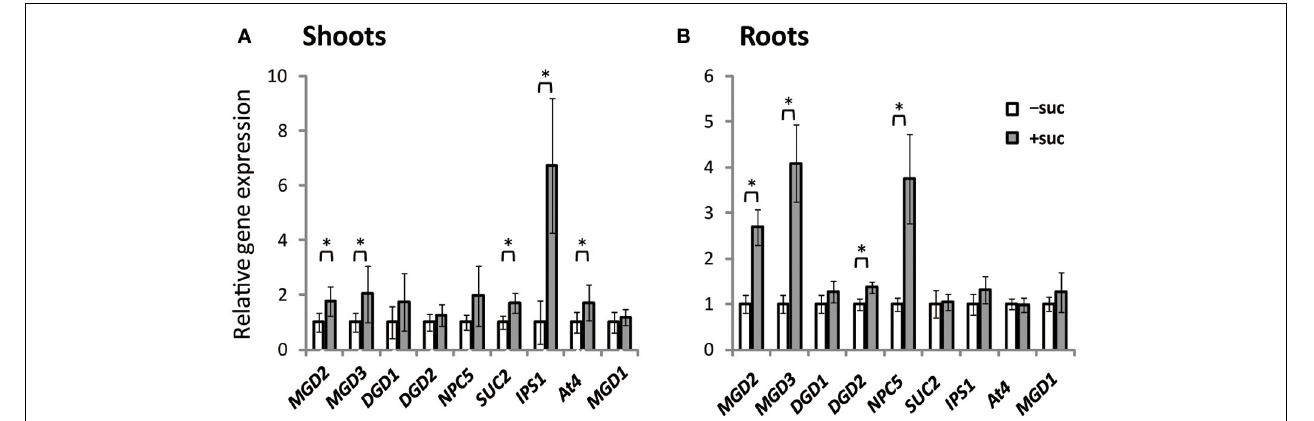
and At4 ), a sucrose transporter gene ( SUC2 ), and a Pi-non responsive galactolipid synthase gene ( MGD1 ) in shoots (A) and roots (B) was analyzed by quantitative RT-PCR. Relative expression was normalized to the mRNA abundance of each respective gene under conditions without sucrose ( − suc). Values represent the mean ± SD from three independent measurements. ∗ P < 0 . 05.